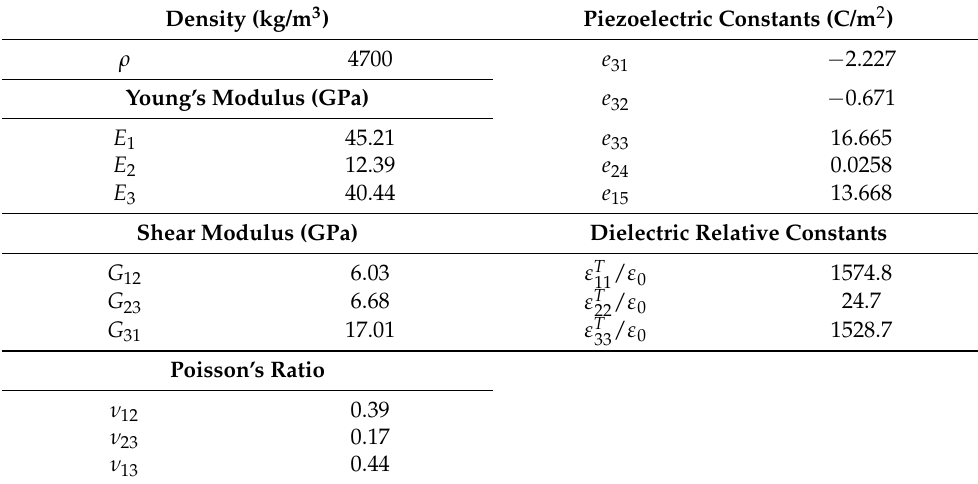
Figure 5. Design space of the problem. The areas beneath the piezo (-electric) patches and the masses M are excluded from the design space. Table 1. Mechanical properties of commercial MFC piezoelectric patches